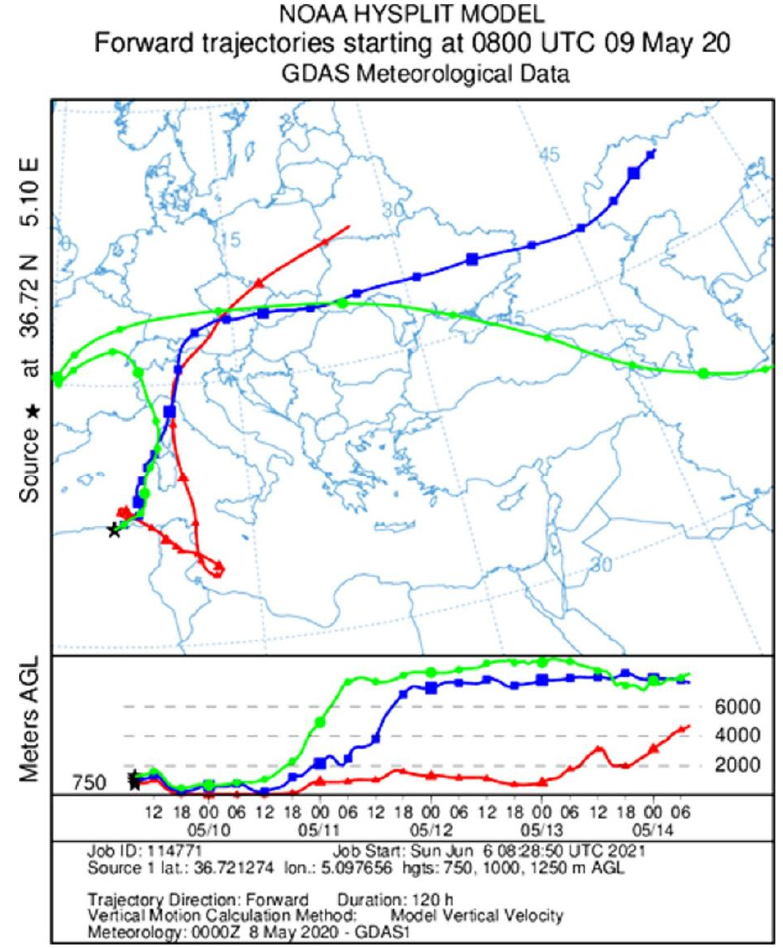
Figure 2. Trajectory of air currents showing the route traveled by the Saharan dust cloud, starting from an altitude of 750 m (red), 1000 m (blue) and 1250 m (green)/(9–13 May 2020). As not all countries traversed by the Sahara dust cloud had measuring stations, AOD data from the main measuring stations located on the trajectory from the source (North Africa) to the study area (Pelinia, Moldova Republic) were taken for analysis: Rome La Sapienza (Italy), Vienna Univie (Austria), Poprad–Ganovce (Slovakia), Strzyzow (Poland), Kyiv–AO (Ukraine), Magurele (INOE), and Timisoara (Romania). The Republic of Moldova, where the target area is located, has only one AOD measuring station, in Chisinau, but no data were recorded there between November 2018 and June 2021. Therefore, the data for the period and the area of interest (Pelinia) are missing. The AOD measuring stations were selected based on the dust cloud’s trajectory toward the northeast. A map with the locations of AOD measuring stations in southeastern Europe is presented in Figure 3. The map includes the position of every AOD station taken into account for this study, considering the dust cloud trajectory area. Other AERONET stations with AOD data were not relevant for this study due to their inadequate location on the trajectory or the unavailability of data for the period of interest at an acceptable quality